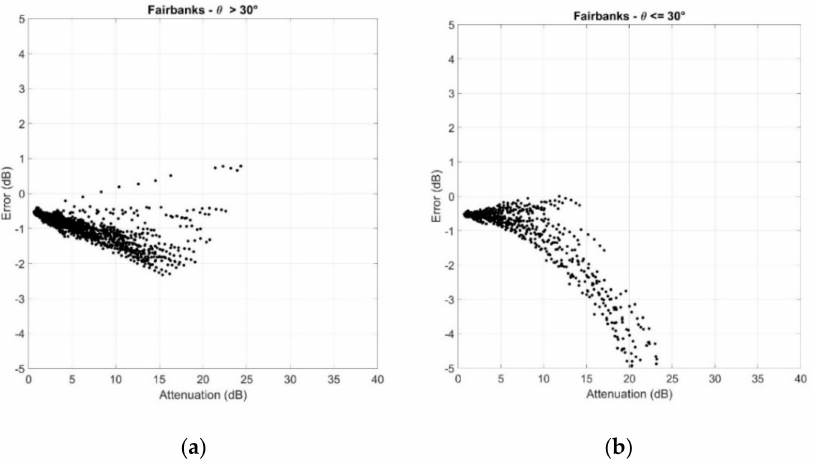
Figure A9. Scatter plots of the error ε = A SST , glo − A SST versus A SST : ( a ) θ > 30 ◦ ; ( b ) θ ≤ 30 ◦ .